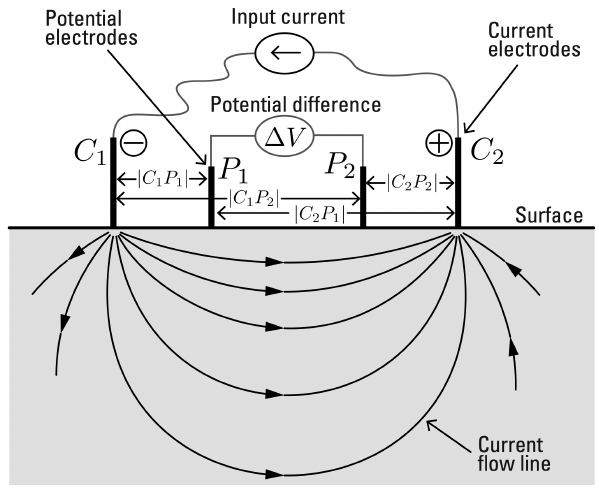
Figure 6. Elementary quadripolar configuration in homogeneous half-space. The current is injected into the subsurface through electrodes ( C 1 , C 2 ) installed into the ground, and the resistivity distribution along a profile is measured (electrodes P 1 , P 2 ). Arrows are flow lines of transmitted current.